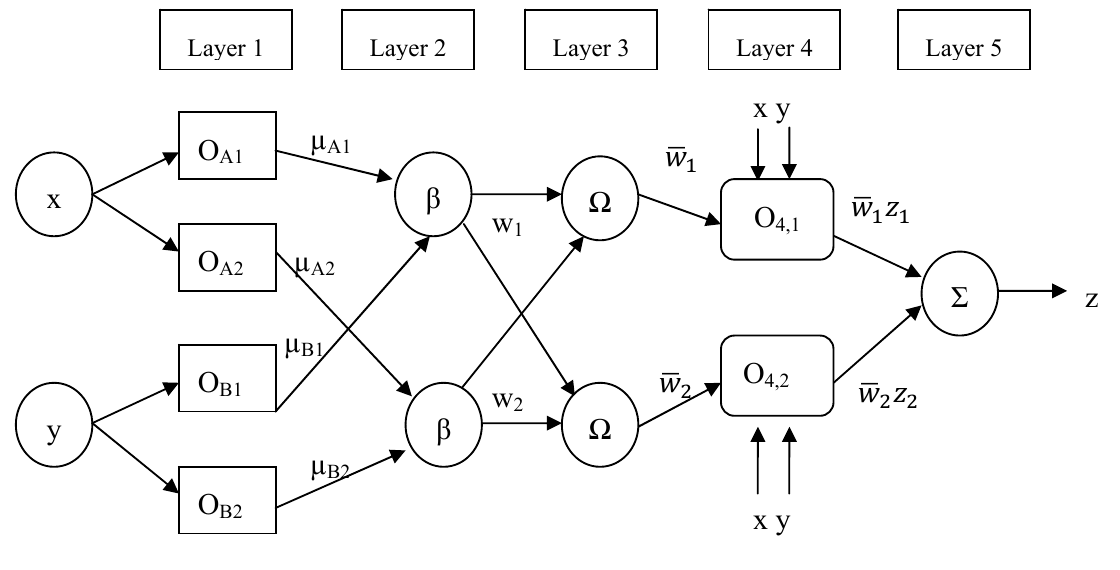
Figure 6. Architecture of the used adaptive neuro-fuzzy inference